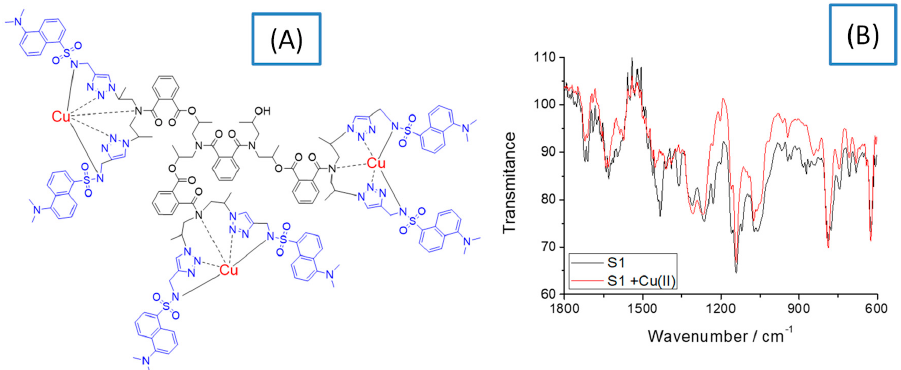
Figure 2. Chemical structure of [Cu 3 (S1)] ( A ) and its FTIR spectrum, compared to that of the free ligand S1( B ).